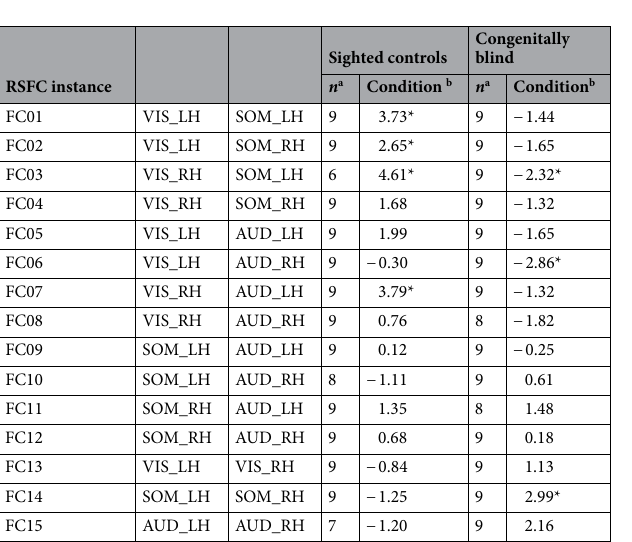
Table 3. Summary of post-hoc, paired-sample t -tests in Study 2. RSFC = resting-state functional connectivity; FC = functional connectivity; VIS = visual region; LH = left hemisphere; SOM = somatosensory region; RH = right hemisphere; AUD = auditory region. a Sample size after outlier removal. b Positive t values indicate that the mean was higher in the eyes closed condition than in the eyes open condition, whereas negative t values indicate that the mean was lower in the eyes closed condition than in the eyes open condition. * p <